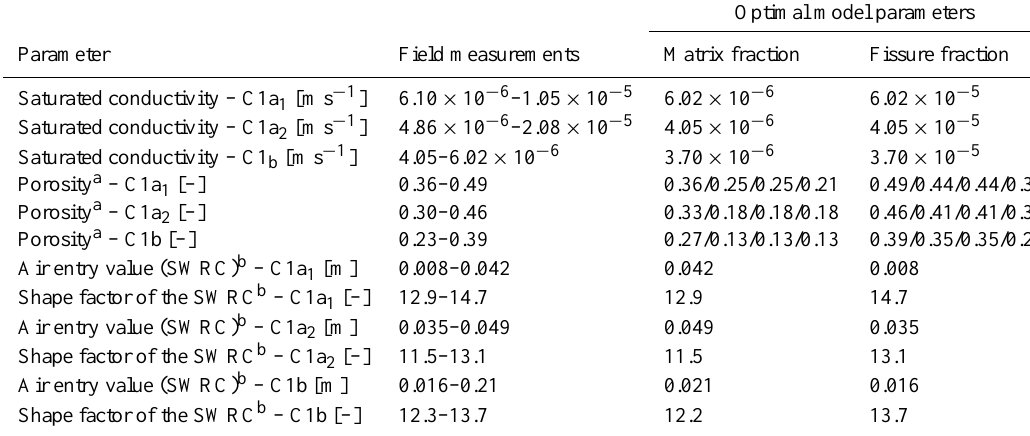
Table 3. The range of field measured parameters (Malet et al., 2005) and the set of parameters after model calibration.